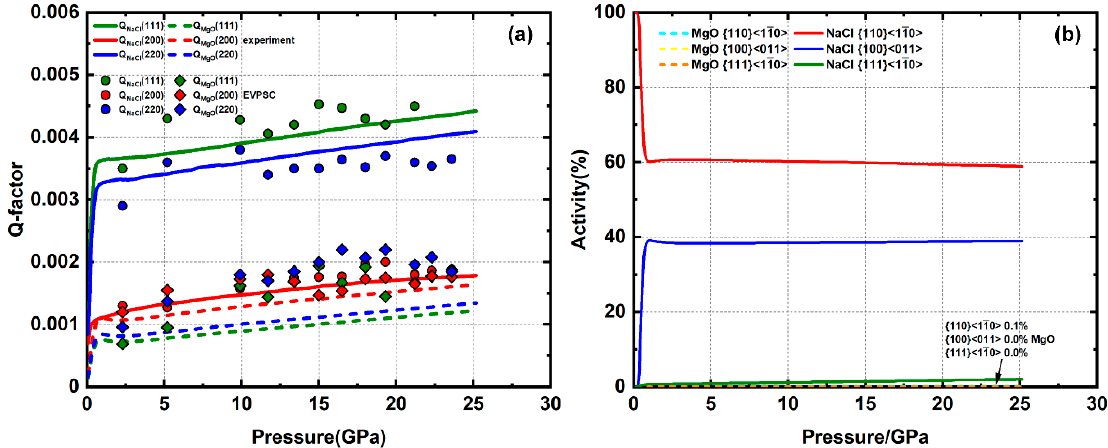
Figure 6. ( a ) Experimental and modeled Q-factors of 20% MgO + 80% NaCl. ( b ) slip system activity of MgO and NaCl.